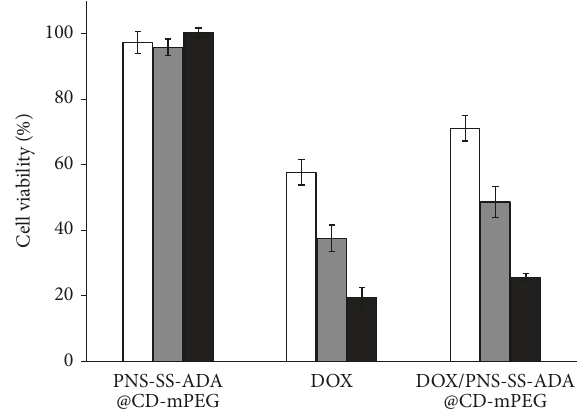
Figure8:ViabilityofHeLacellsincubatedwithPNS-SS-ADA@CD- mPEG (100 𝜇 g/mL), free DOX (5 𝜇 g/mL), and DOX/PNS-SS- ADA@CD-mPEG (eq. DOX conc.) for 24, 48, and 96h. The cells were exposed to the samples for the indicated times. The data represent the mean values ± the standard deviation (SD) (𝑛 = 4)